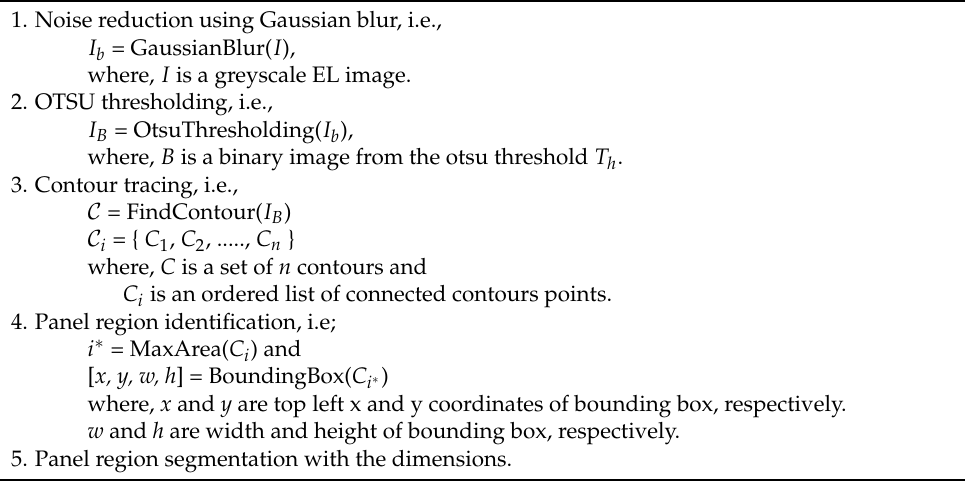
Algorithm 2 EL panel region extraction.